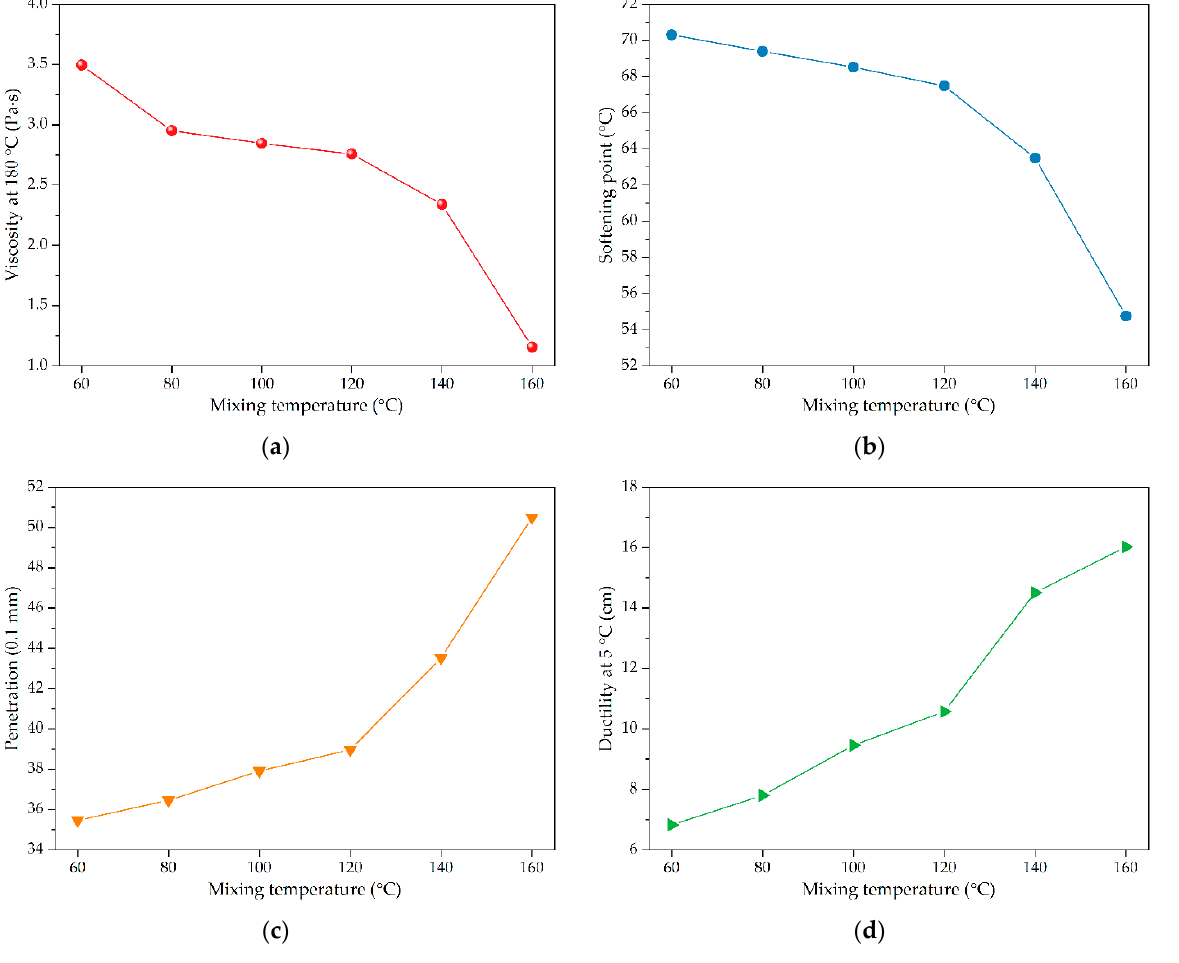
Figure 4. The physical properties of asphalt modified by crumb rubber treated with different mixing temperatures (i.e., 60, 80, 100, 120, 140, 160 °C): ( a ) viscosity at 180 °C; ( b ) softening point; ( c ) pene- tration; ( d ) ductility at 5 °C.